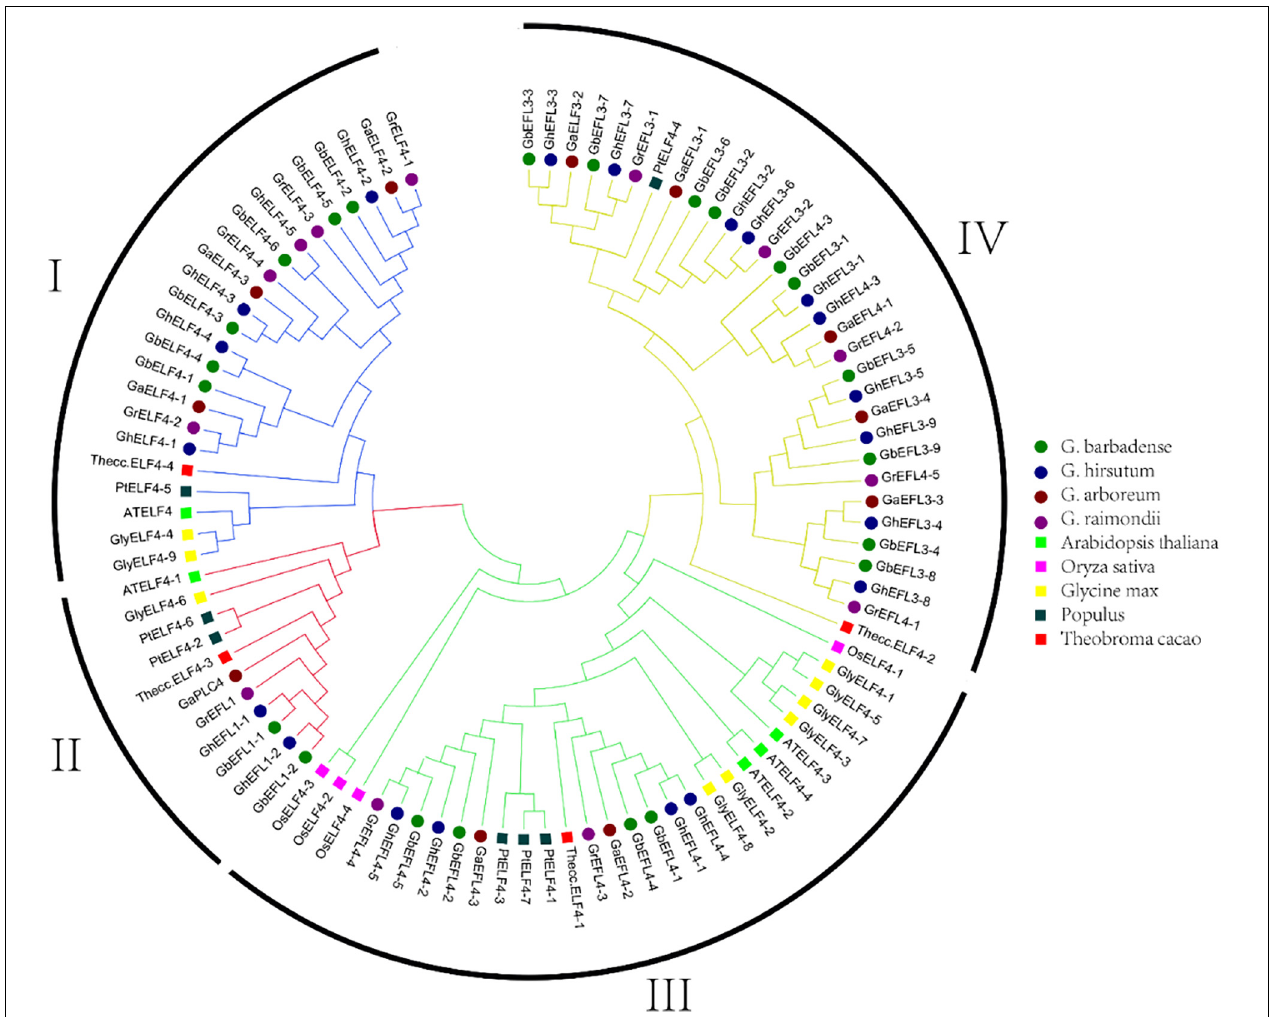
FIGURE 2 | Phylogenetic tree of ELF4s. The 95 ELF4 protein sequences of G. raimondii , G. arboreum , G. hirsutum , G. barbadense , A. thaliana , Populus trichocarpa , Oryza sativa , Theobroma cacao, and Glycine max were aligned with ClustalX 2.0, and the phylogenetic tree was